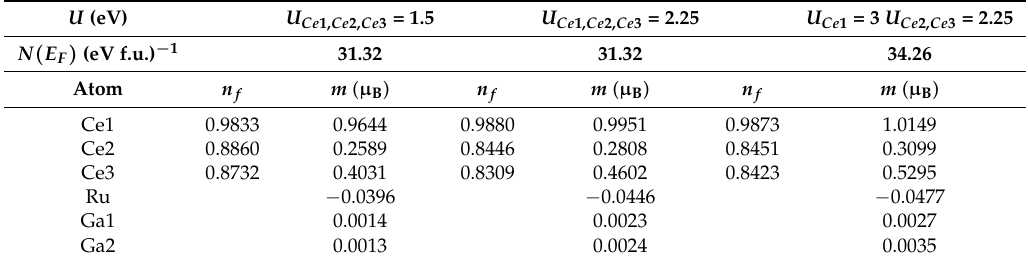
Figure 4. ( a ) Valence band XPS spectrum of Ce 9 Ru 4 Ga 5 (brown points) compared to the spin-resolved total density of states (blue line) calculated for U Ce 1 = 3 eV and U Ce 2, Ce 3 = 2.25 eV. ( b ) Total and partial DOS in Ce 9 Ru 4 Ga 5 , calculated as in panel ( a ), compared to the experimental XPS data. Table 3. Results of the LSDA+U calculations performed for Ce 9 Ru 4 Ga 5 with different values of the correlation energy U , where n f stands for the number of 4 f electrons and m is the total magnetic moment per